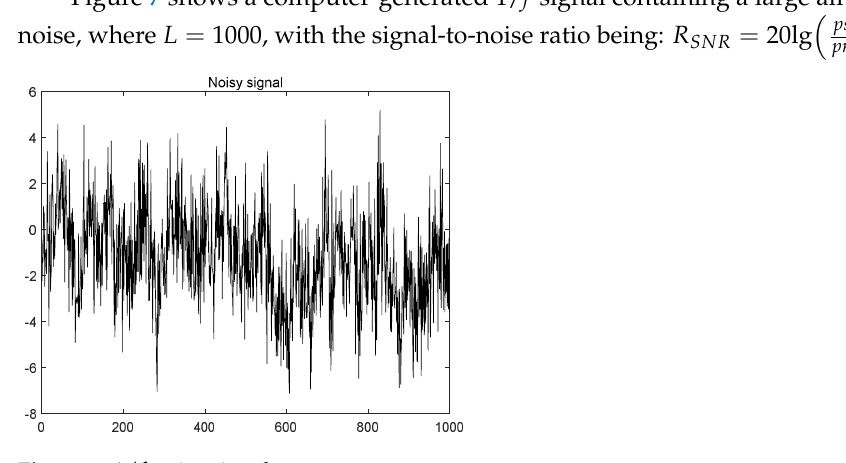
Table 2. Parameters of the PSO algorithm.